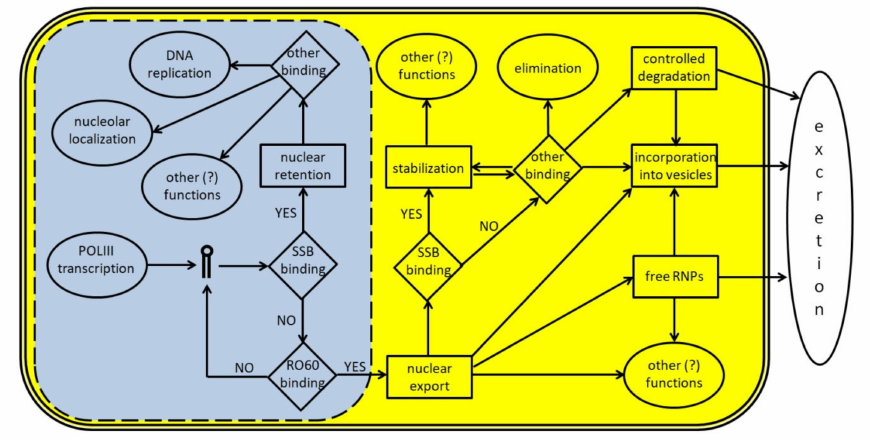
Figure 3. A schematic representation of Y RNA life cycle. The light blue area represents the nucleus (the dotted line indicates the presence of nuclear pores) and the molecular events occurring inside it; the yellow area represents the cytoplasm; the white space represents the surrounding